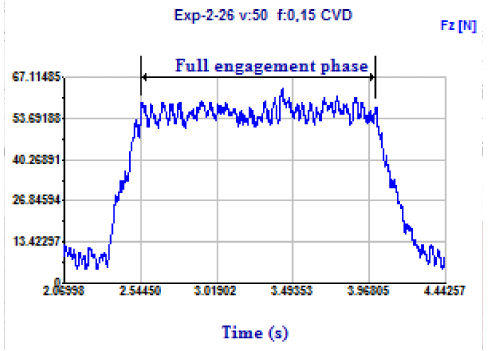
Figure 1. Thrust force profile vs. machining time for the experimental run at V c = 50 m/min and f = 0.15 mm/rev when using the CVD-coated drill bit.